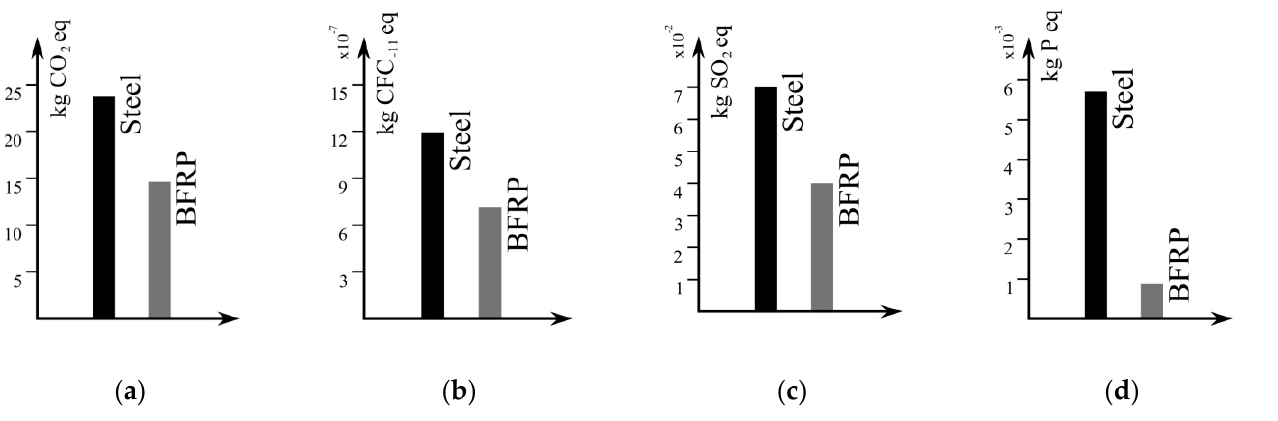
Figure 7. A comparison between the environmental markers (climate change emissions ( a ), ozone depletion ( b ), terrestrial acidification ( c ), and freshwater eutrophication ( d )) for structural steel and BFRP [45].